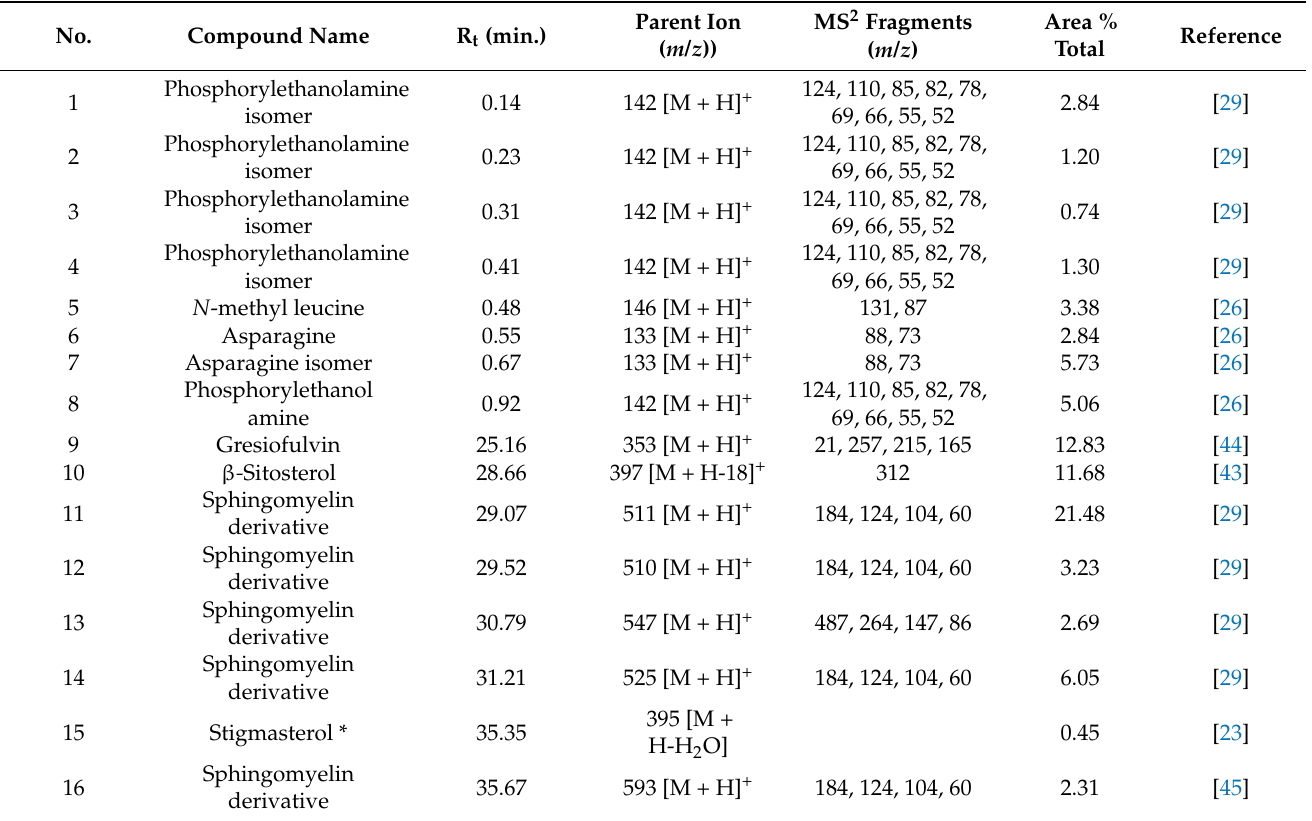
Table 2. Metabolites tentatively identified in dichloromethane fraction using UPLC-ESI-MS/MS analysis in positive ionization